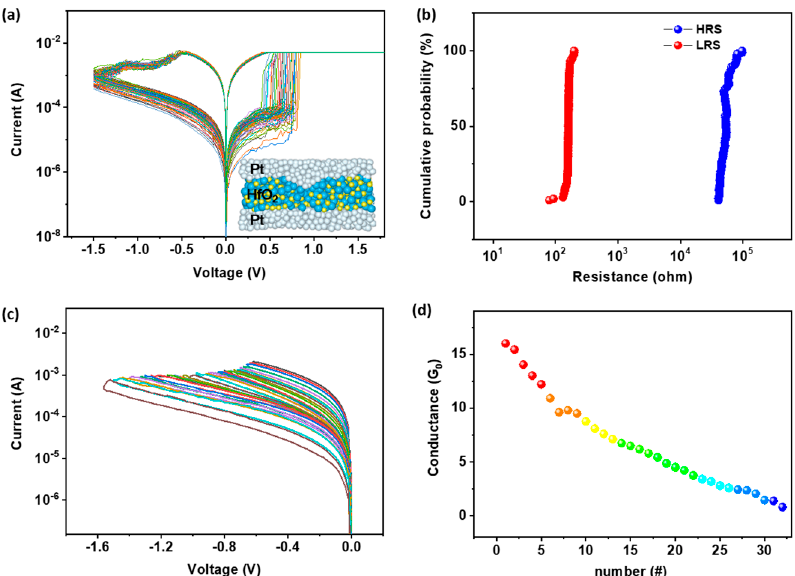
Figure 2. ( a ) Current–voltage characteristics of Pt/HfO x /Pt memristor device showing resistive switching with an ON/OFF ratio exceeding 10 3 . Inset shows the structure of the device, with electrode protrusion extending into the hafnium oxide switching layer. ( b ) Histogram of the device resistances in the ON and OFF state. ( c ) Continuous regulation of the device current in the negatively biased reset processes. ( d ) Evolution of the device conductance as a function of the voltage pulse stressing numbers.